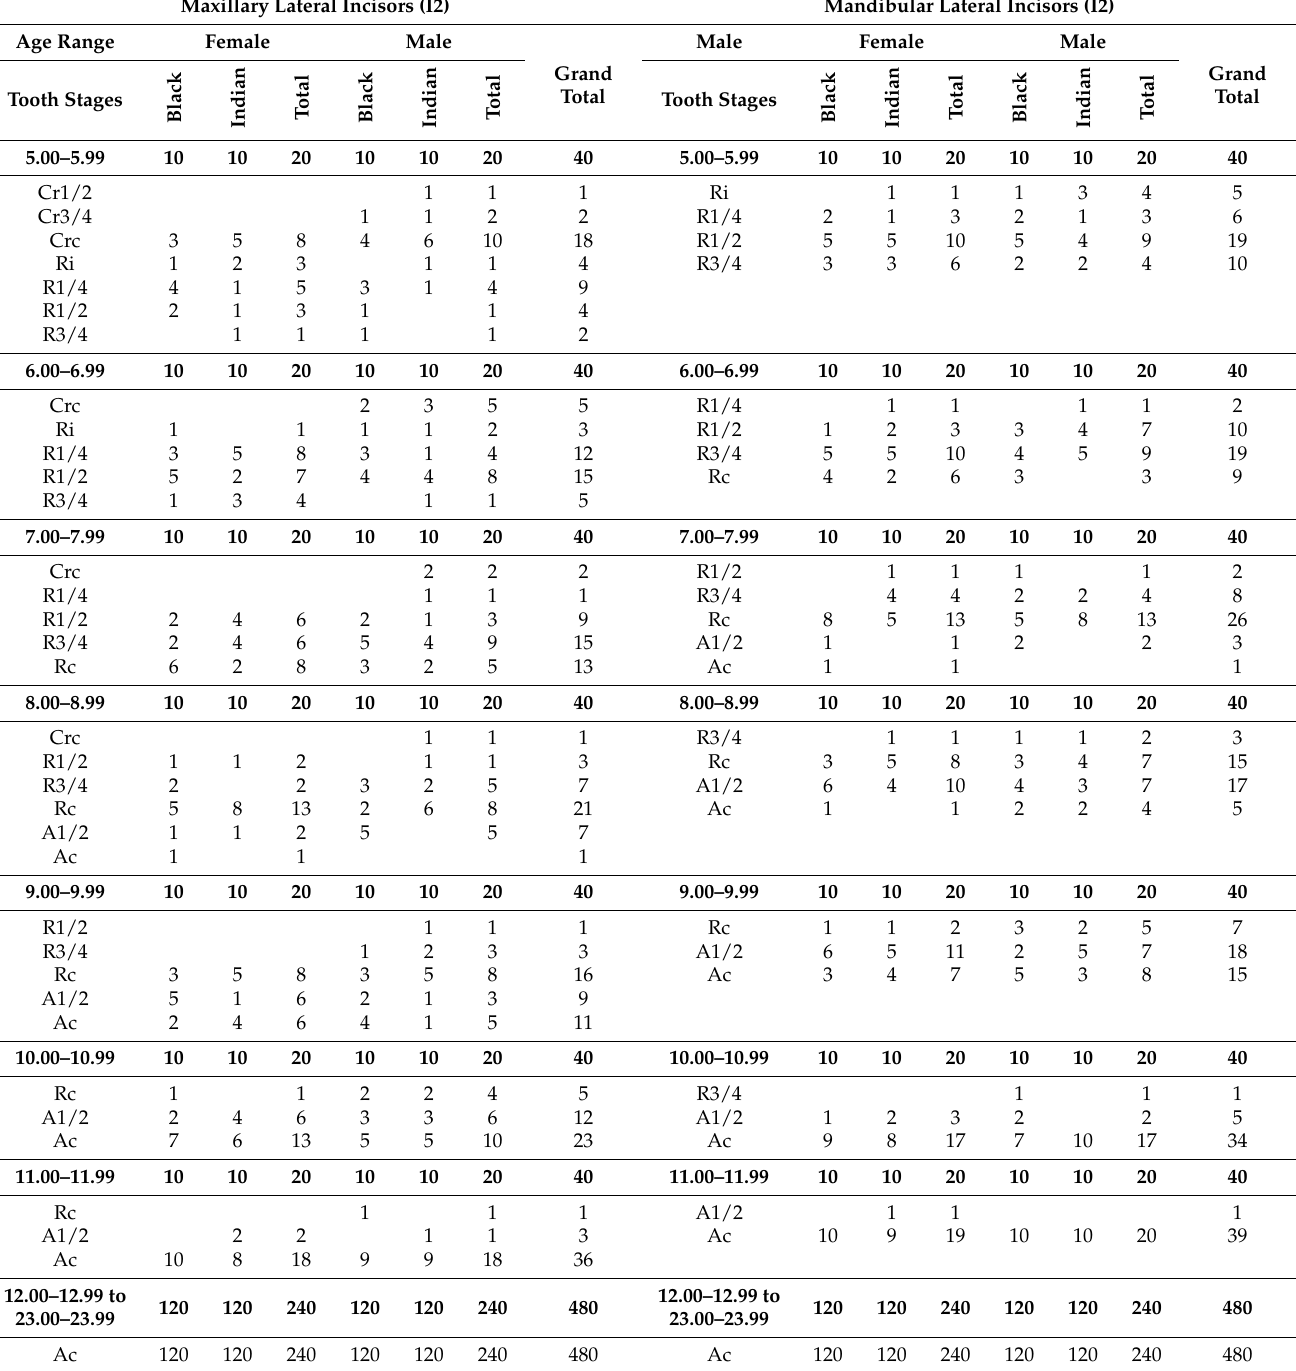
Table A2. Frequencies of the tooth development stages of the lateral incisors for the SA Black and Indian population